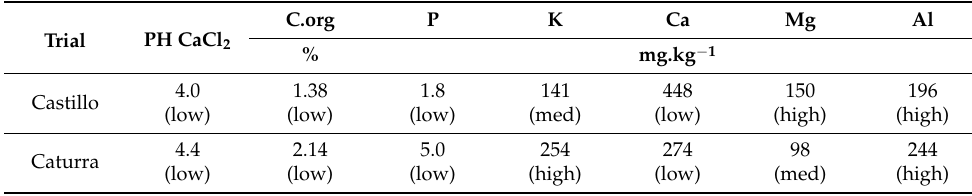
Table 2. Soil fertility properties for the experimental